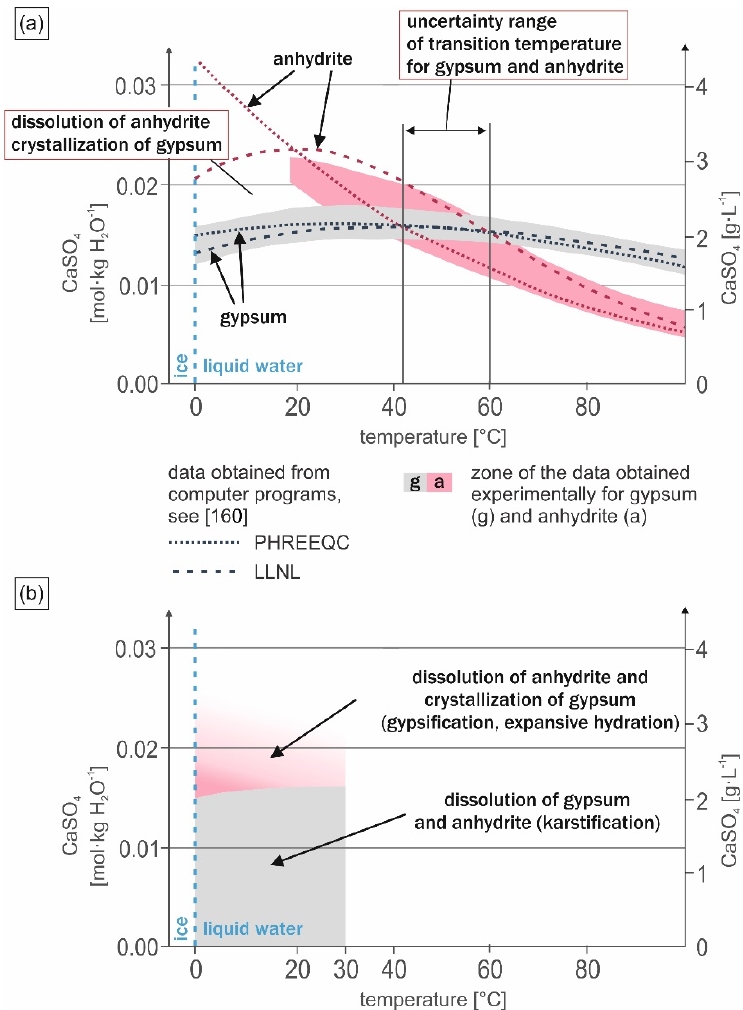
Figure 10. ( a )—Graphs of gypsum and anhydrite solubility in pure water depending on temperature, based on multiple sources (according to Van Driessche et al. [160]), showing the zone in which the anhydrite dissolves and simultaneously gypsum crystallizes (according to Butscher et al. [20]; uncertainty range of the temperature of transition between gypsum and anhydrite according to Freyer and Voigt [16]). Note that for temperatures below 40 °C, experimental data appear to suggest that anhydrite solubility curve according to LLNL gives better approximation of the real values. ( b )—interpreted conditions of karstification (dissolution of gypsum and anhydrite) and expansive anhydrite hydration (dissolution of anhydrite and gypsum crystallization) at Dingwall; further explanations in the text.